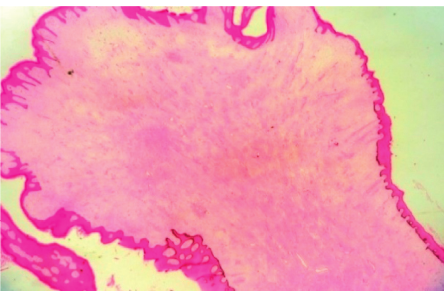
Figure 4: A hematoxylin and eosin stain of the fibroepithelial polyp showing a verrucous surface covered by acanthotic stratified squamous epithelium with hyperkeratosis. The stroma is hypo- cellular and collagenous.